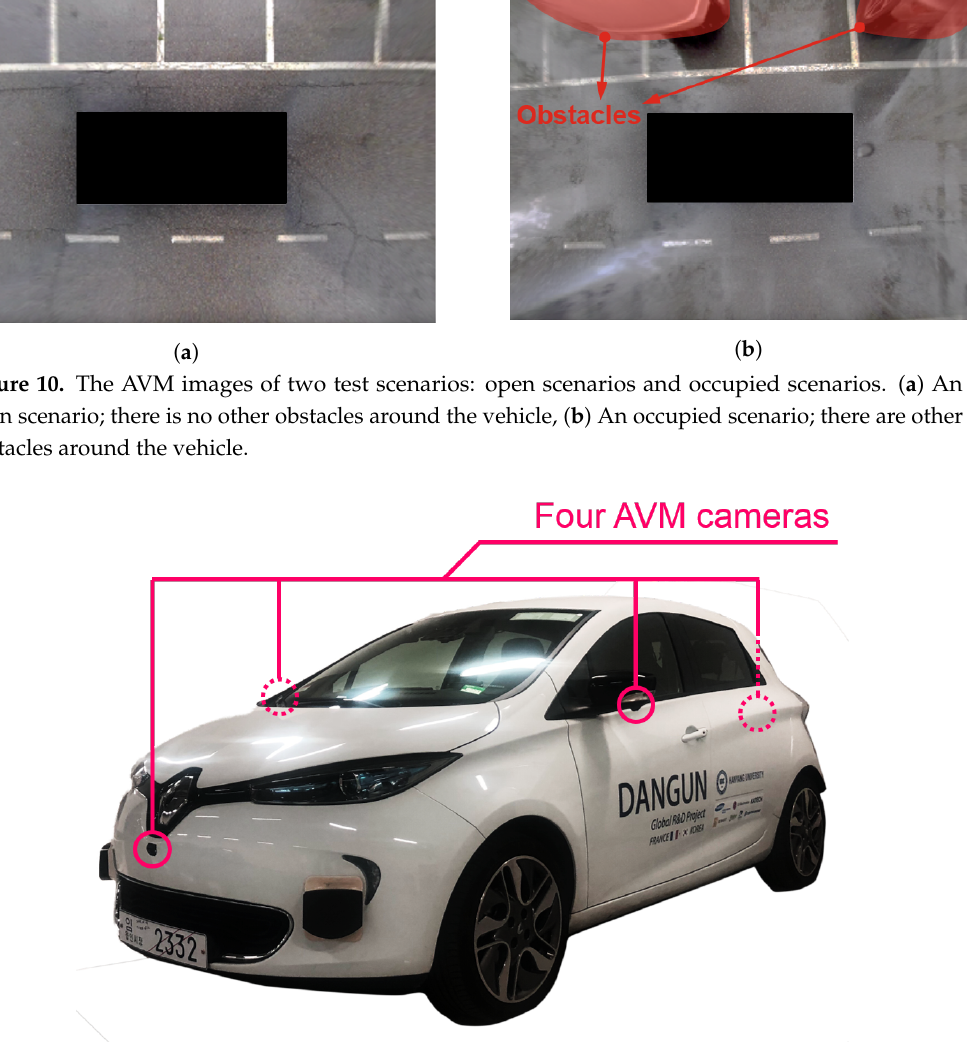
Figure 11. Test vehicle ZOE equipped with AVM and motion